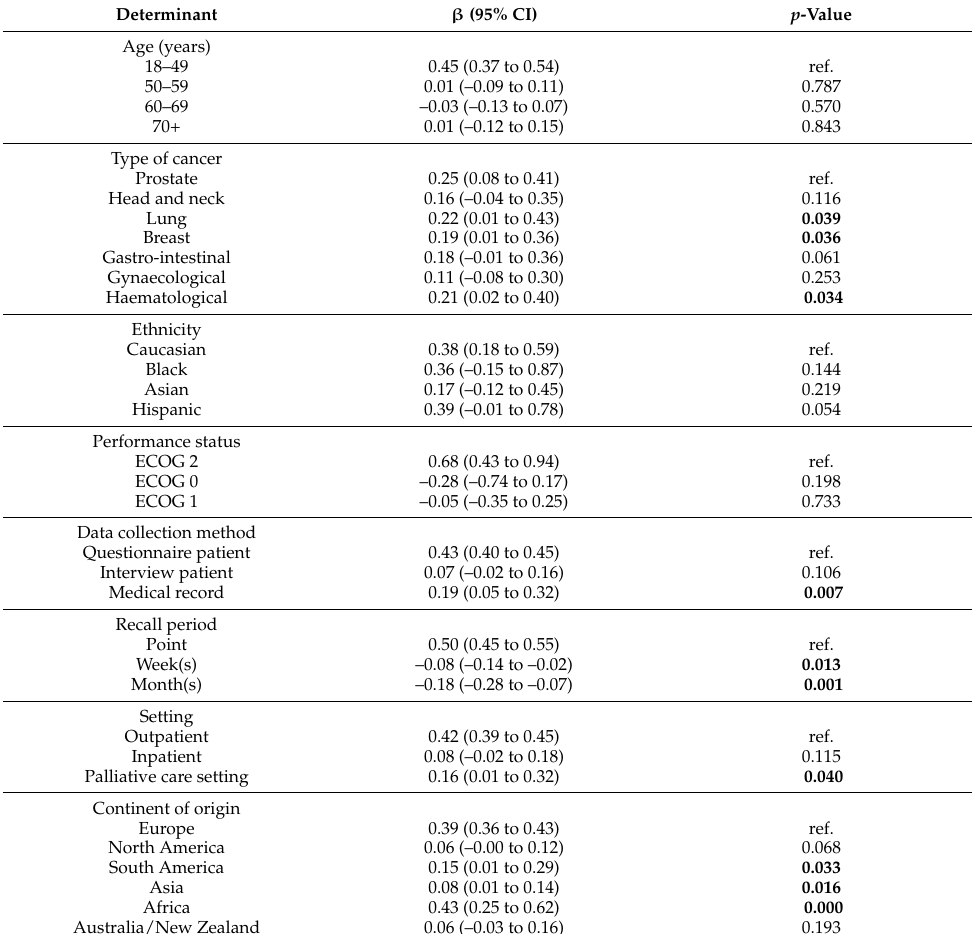
Table 10. Meta-regression to explore determinants of pain